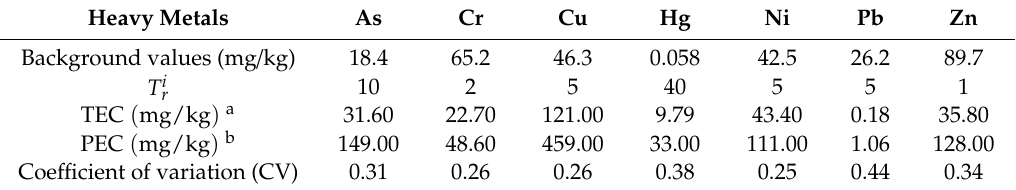
Table 1. Soil background values, toxic response coe ffi cients, Consensus-Based Sediments’